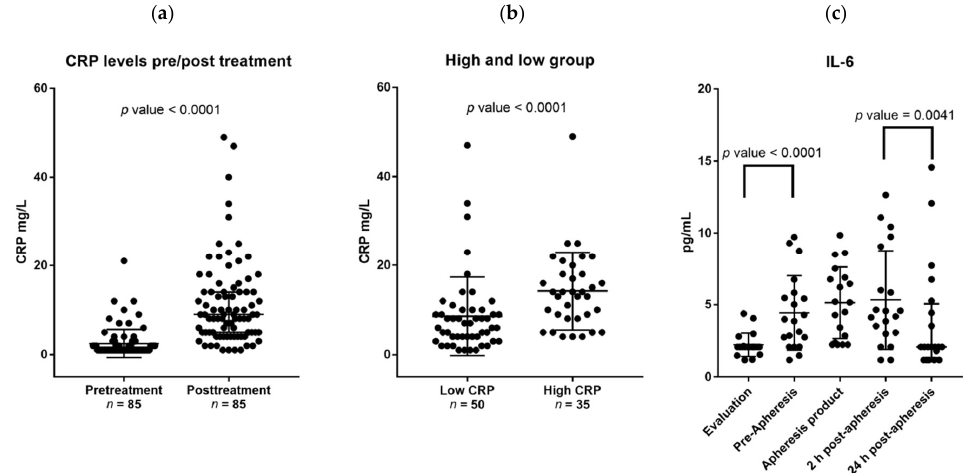
Figure 1. Effects of granulocyte colony-stimulating factor (G-CSF) on C-reactive protein (CRP)